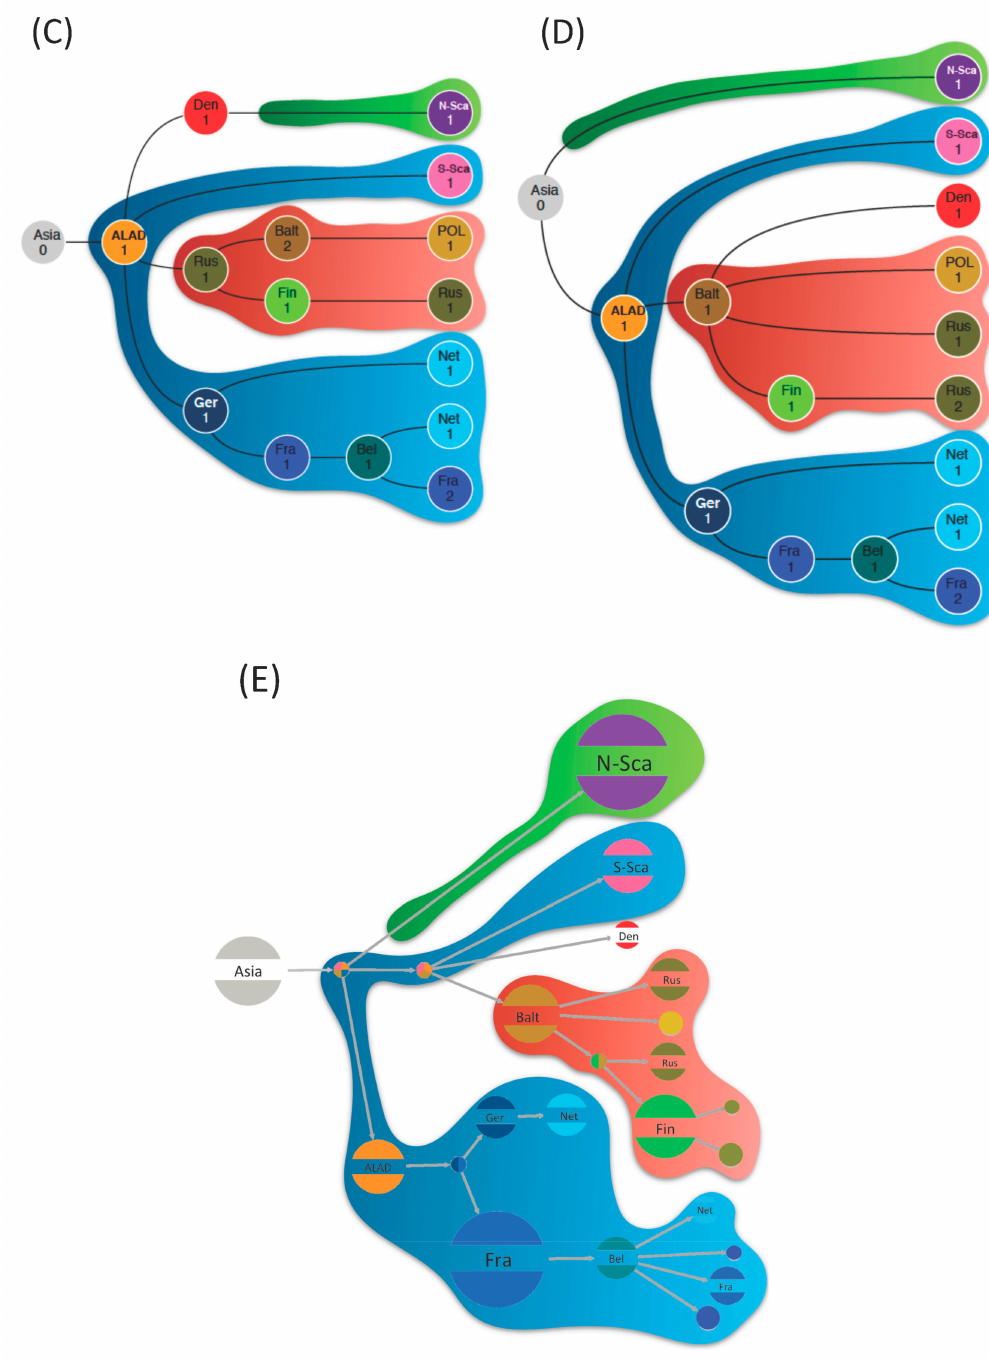
Figure 2. Ancestral geographical reconstructions based on phylogenetic trees obtained by the Bayesian method (Beast program) ( A ) and ML methods, F81 algorithms, (PastView program) ( B ) from the complete coding sequence of the S segment. The red arrows point the nodes in disagreement between Bayesian and ML methods. Tree-like representations of transitions were computed with BEAST ( C ), PastView ( D ), and PastML ( E ) programs. For ( C ) and ( D ), transition maps are summarized with PastView program and numbers indicate the counts of identical transitions having the same ancestor. For ( E ), transition map is done by PastML program and circle diameters are proportional to the number of tips of the initial tree contained in each cluster. Consensus transitions between the three programs are highlighted in blue, red, and